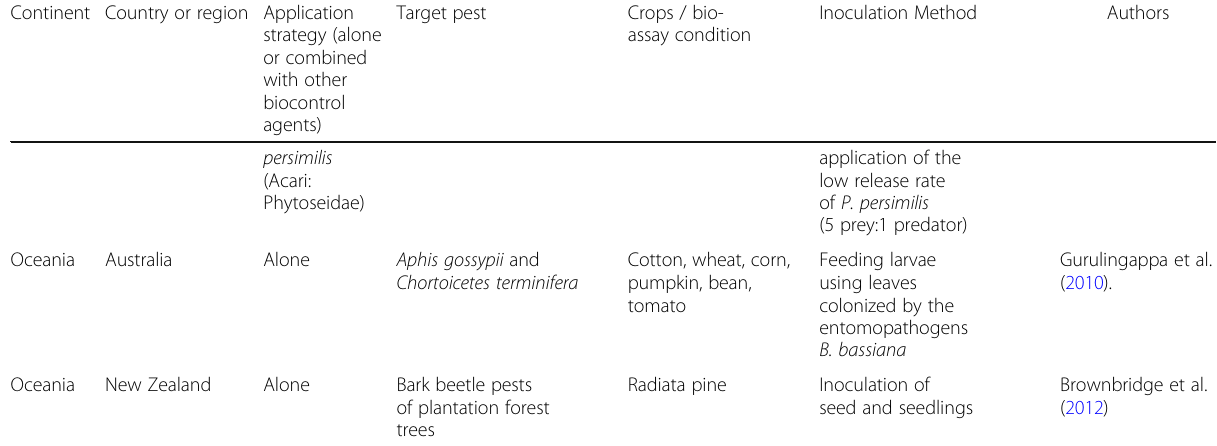
Table 1 Summary of the control programs that successfully used Beauveria bassiana for crop protection from 2009 to 2019 (Continued) Continent Country or region Application strategy